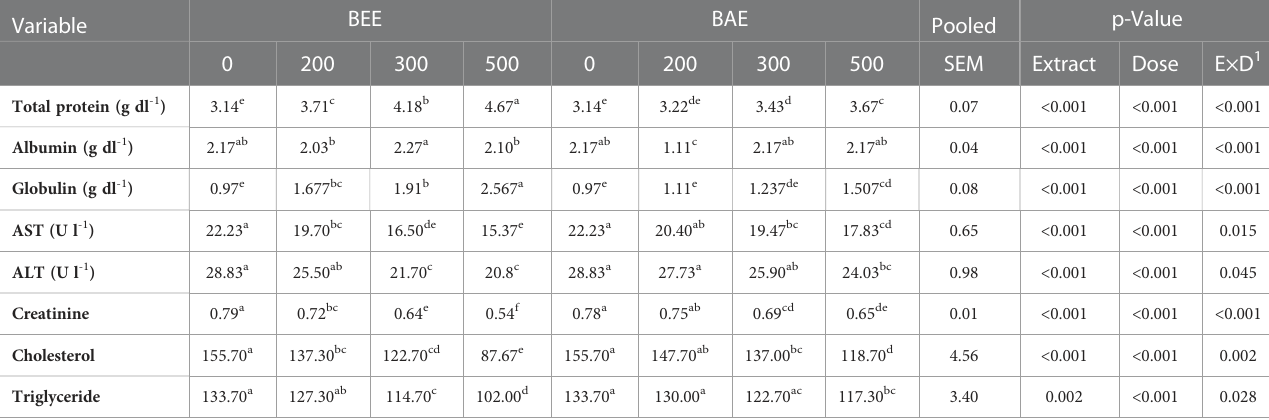
TABLE 5 Effect of dietary supplementation of basil ethanol and aqueous extracts (mg kg -1 of feed) on serum biochemical examination of Nile tilapia, O. niloticus .